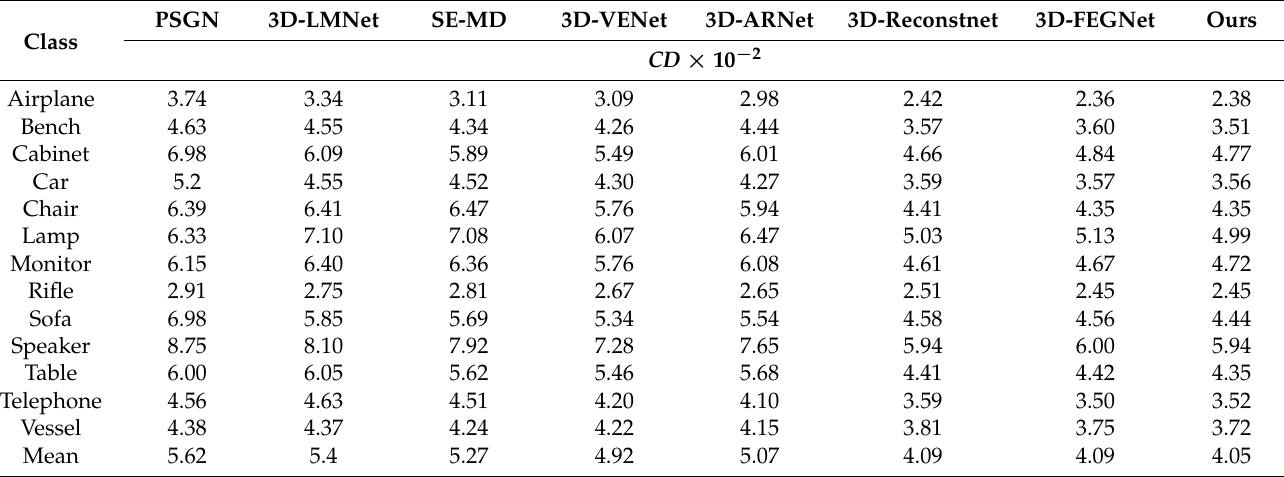
Table 3. Reconstruction results on ShapeNet evaluated by CD.